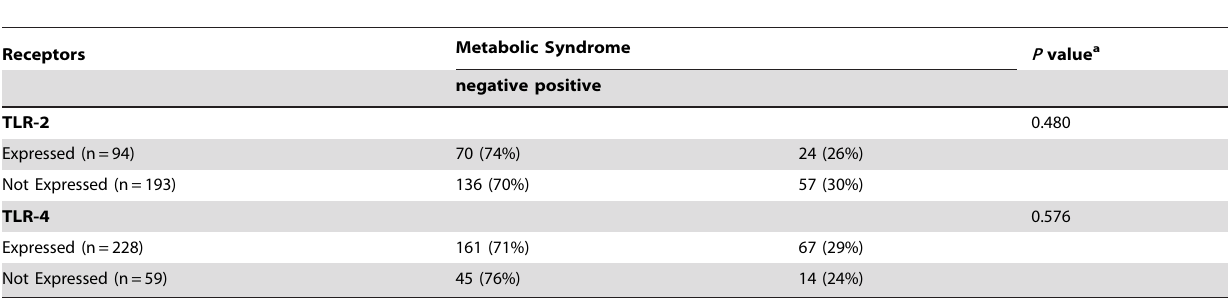
Table 3. Association between the expression of Toll-like receptors and the metabolic syndrome in postmenopausal women with (positive, n =86) and without (negative, n= 225) metabolic